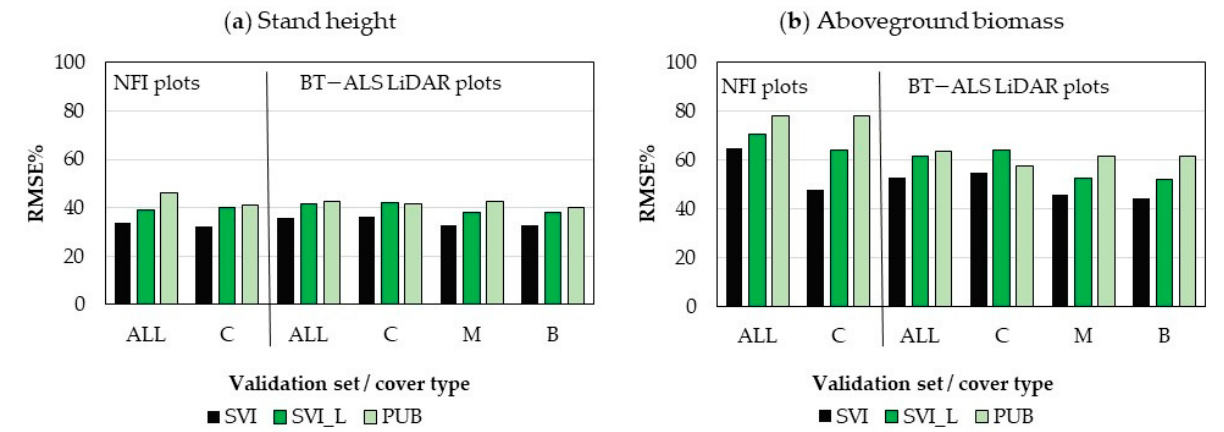
Figure 10. Percent root mean square error (RMSE%) for ( a ) stand height and ( b ) AGB relative to the validation datasets comprising NFI plots and BT − ALS LiDAR plots using all samples (ALL) then partitioned by forest cover type (C: conifer, M: mixedwood, B: broadleaf) for SVI maps compared to Landsat-based SVI_L maps and published (PUB) maps.